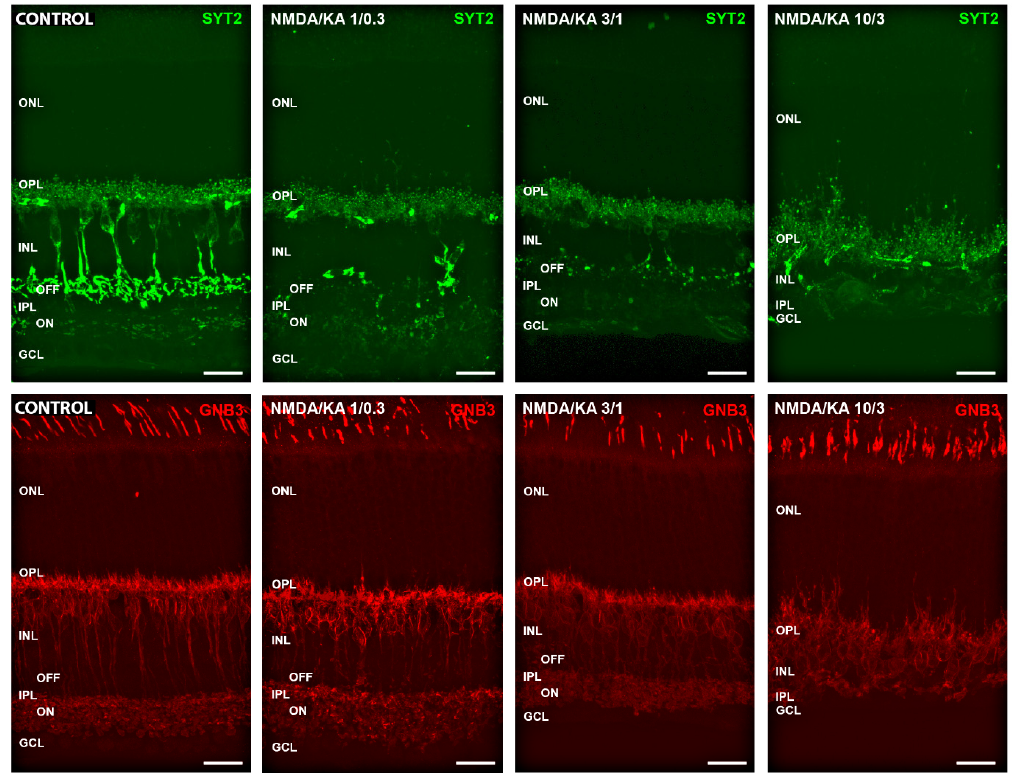
Figure 6. Effect of different NMDA/KA doses on retinal interneurons. Cone bipolar cells were labeled with Syt2 (OFF bipolar cells, green) and GNB3 (ON bipolar cells, red). The axon terminals